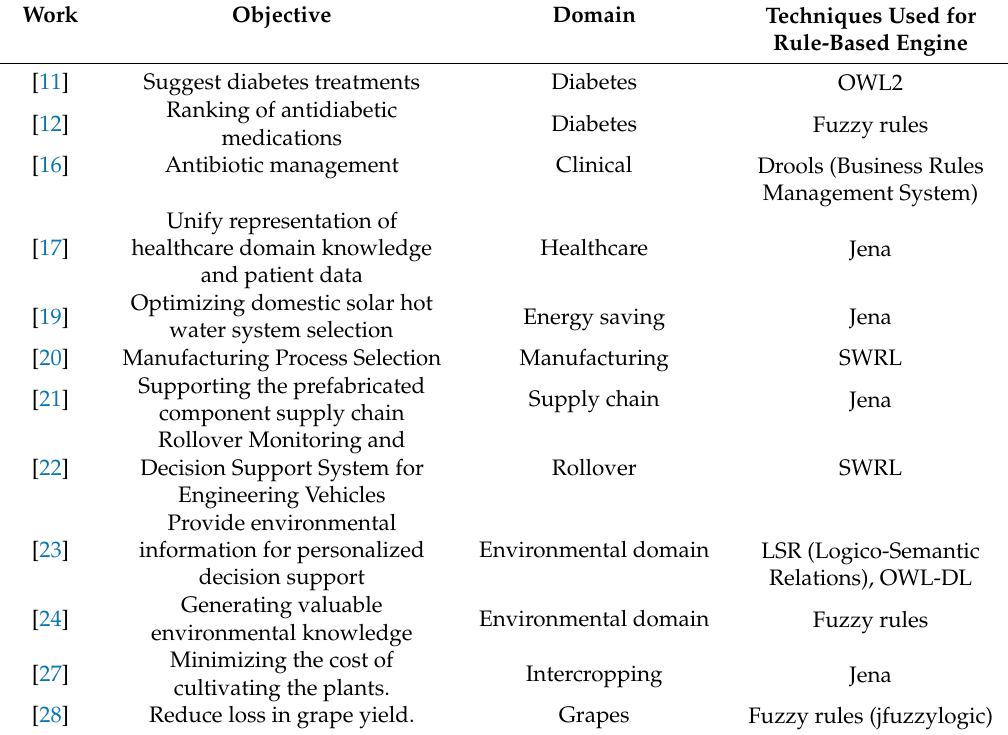
Table 1. Comparative analysis of ontology-based decision-support